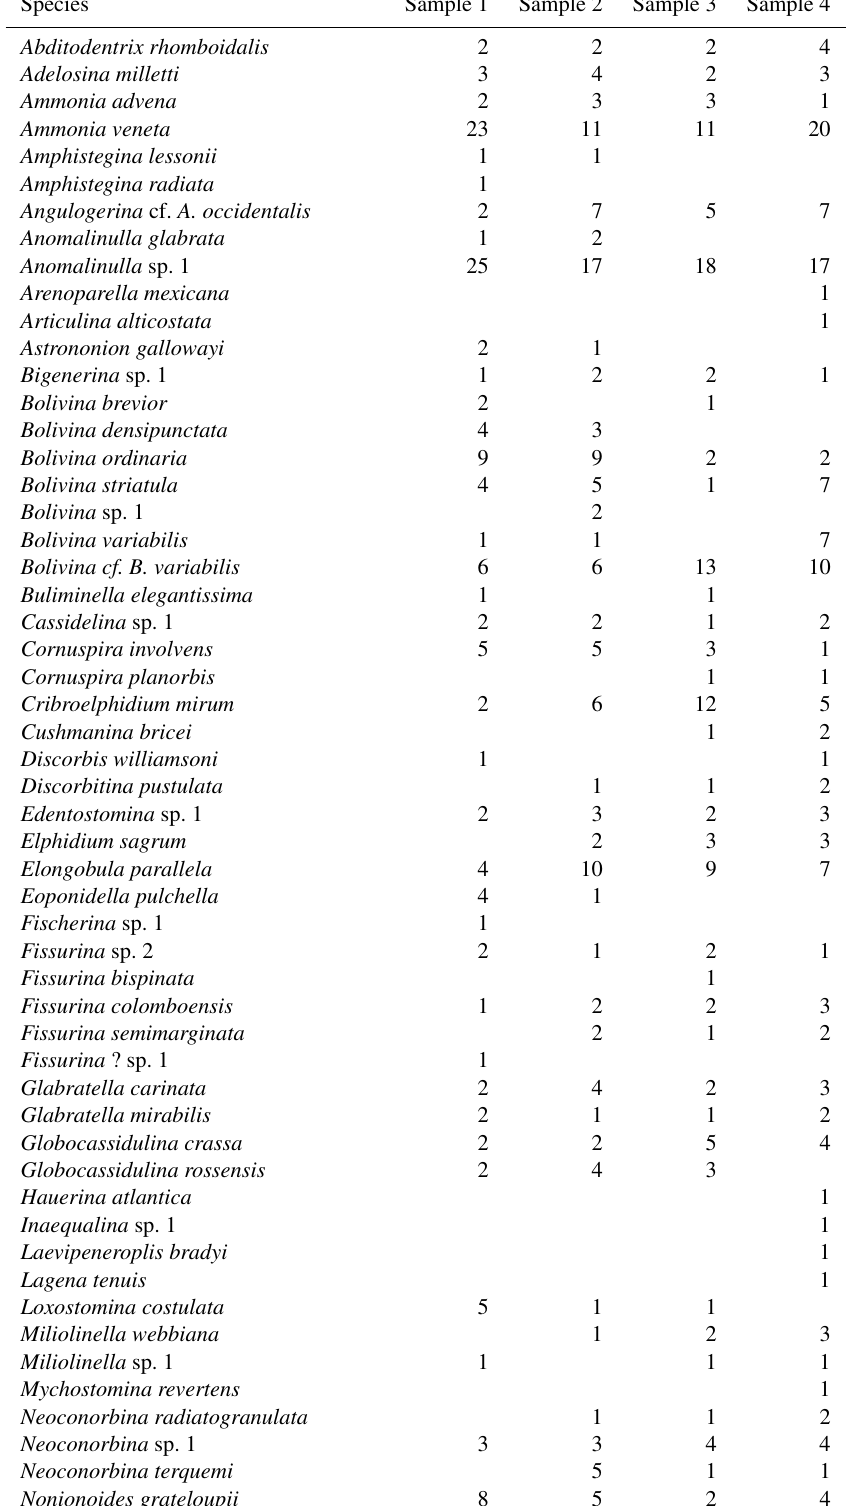
Table 1. Alphabetical list, abundance of all species of foraminifera identified, and total abundance of specimens, genera, and species in the samples from the Mamanguape River